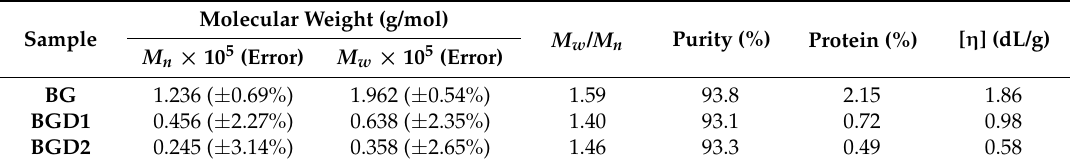
Table 1. Molecular weights ( M w ), polydispersities ( M w / M n ), intrinsic viscosities ([ η ]), purities, and proteins of Qingke β -glucans.